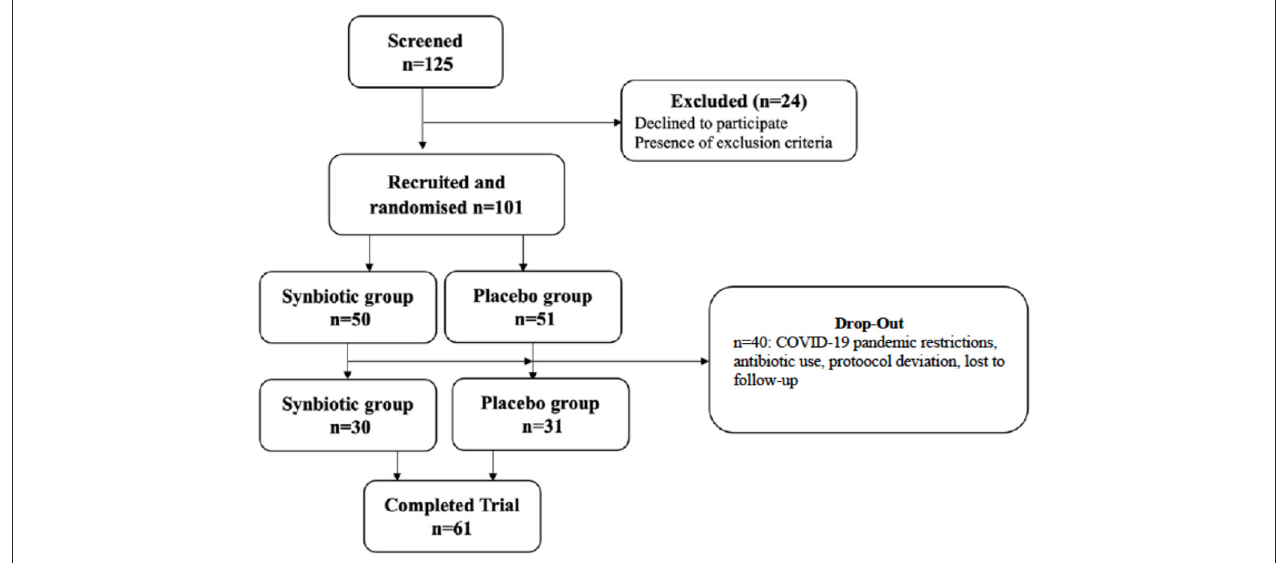
FIGURE 1 | Flow chart of the study.